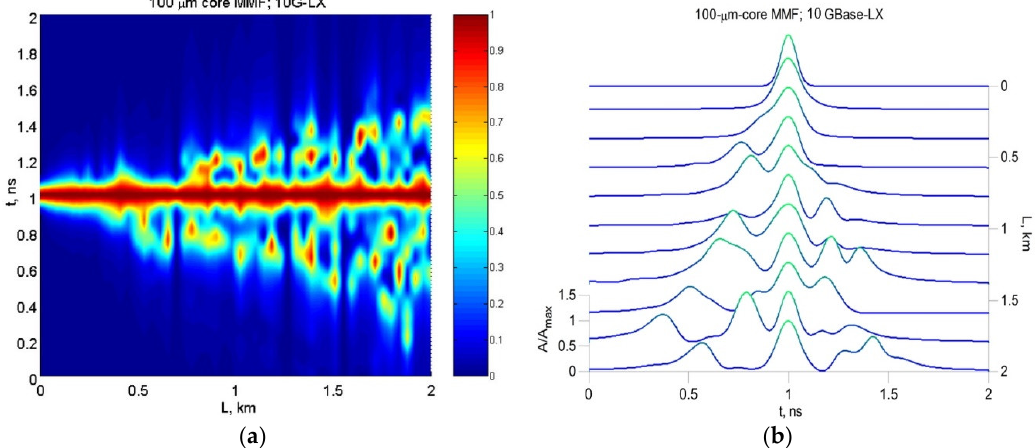
Figure 10. 10GBase-LX optical pulse dynamics during propagation over a 100 μm core MMF with a total length of 2 km without special launching conditions: ( a ) pulse dynamics; ( b ) diagram of pulse propagation.